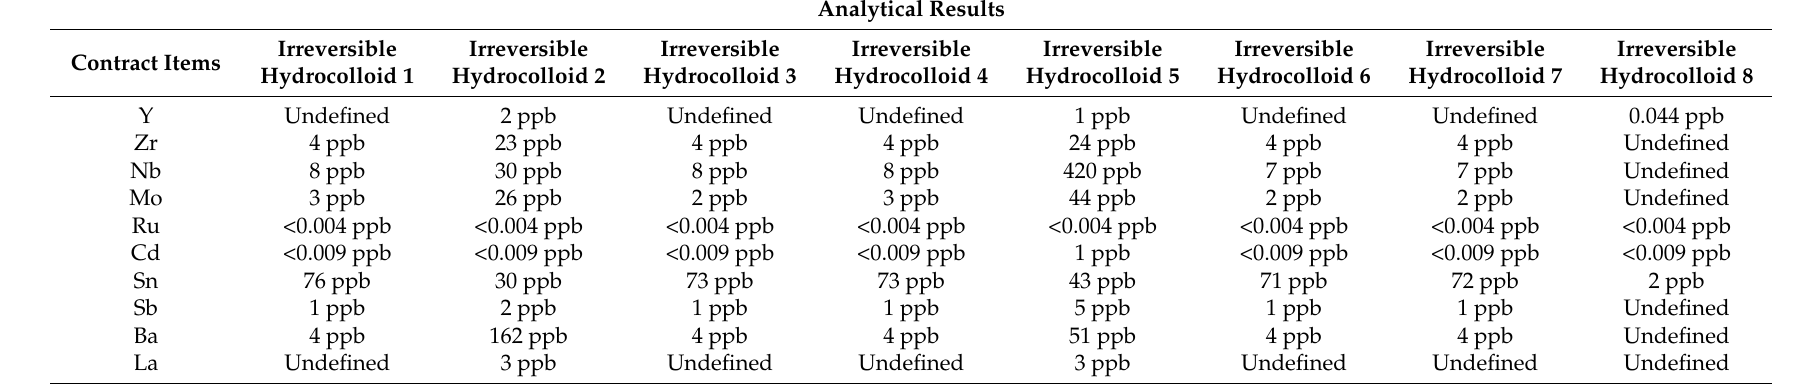
Table 3. Analytical results of the amount of Y, Zr, Nb, Mo, Ru, Cd, Sn, Sb, Ba and La in irreversible hydrocolloid.